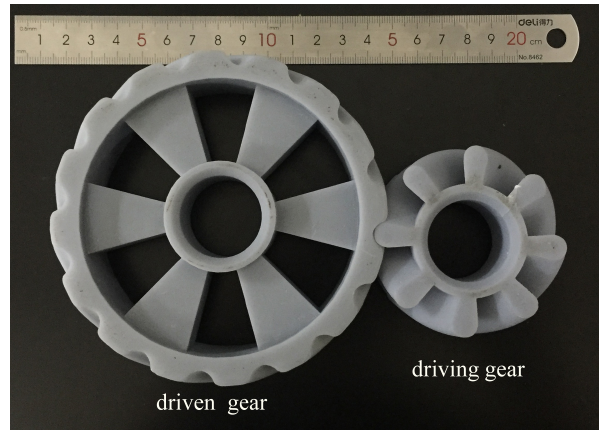
Figure 3. A pair of gear drive samples produced by a 3D